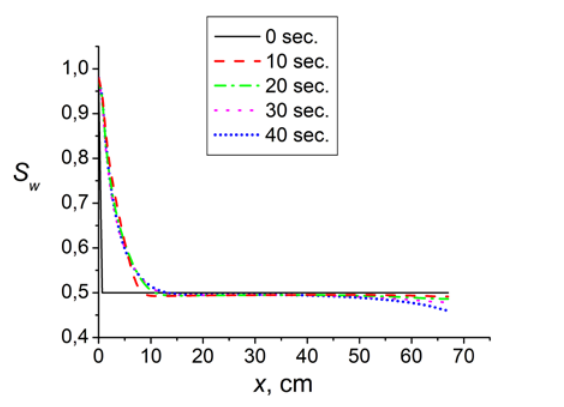
Fig. 3. Gas phase pressure in the heat pipe at different time moments.